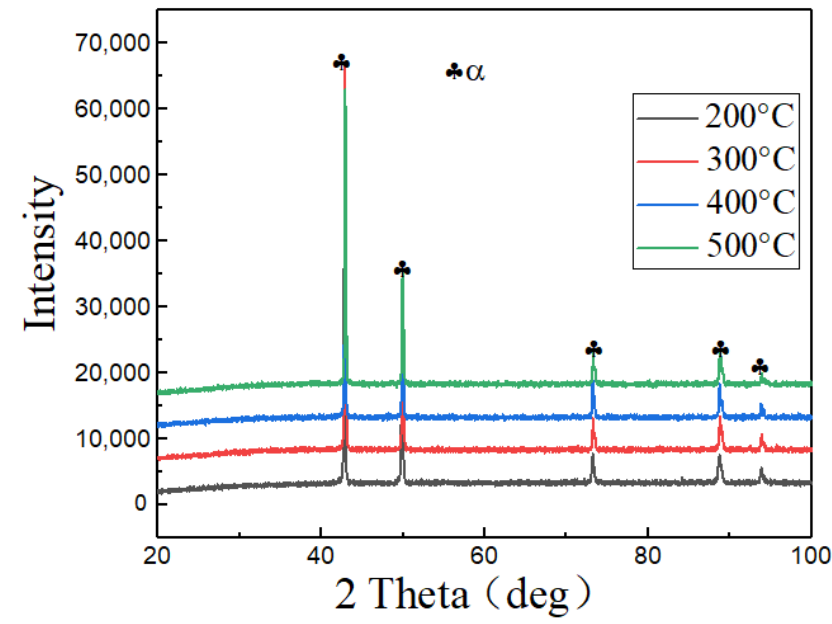
Figure 7. XRD patterns of the Cu-Sn-P alloy at different temperatures.